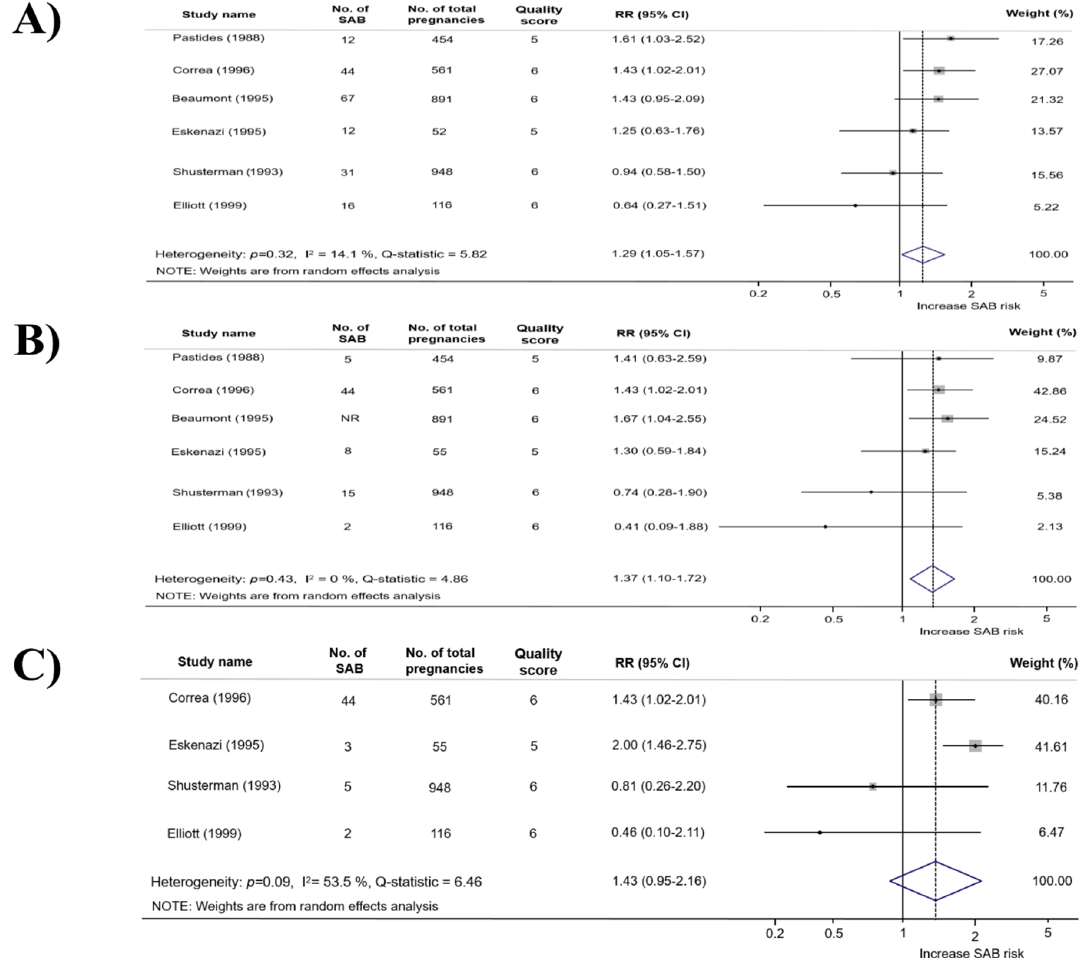
Figure 2. Meta-analysis for cohort and case-controls studies presenting the association between the risk of spontaneous abortion and: Fab work ( A ); photolithography work ( B ); and ethylene glycol ether exposure ( C ).